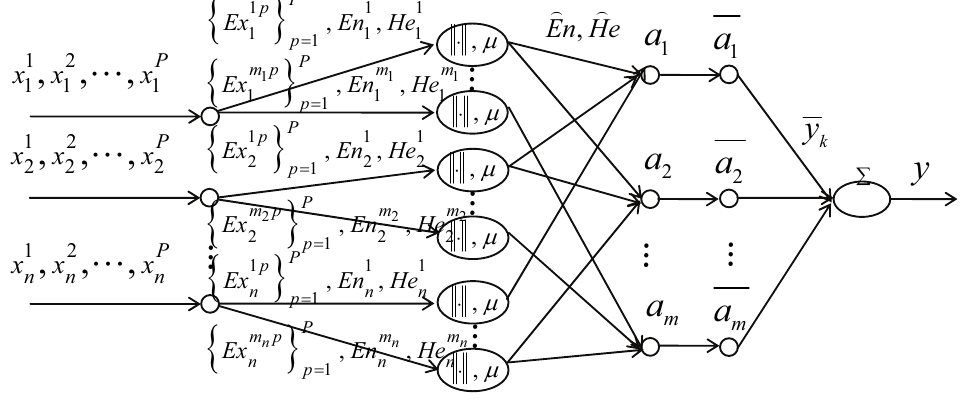
Fig.2. Cloud process neural network is a measurement norm used to measure the matching X and j Ex in process sampling degree between i i interval [0,T ], e.g. Euclidean distance, discrete Fréchet distance or mean Hausdorff distance. (iii) Rule layer: Each node represents “soft-and” operation and matches cloud rule to compute the a of this rule, activation degree k . “Soft-and”